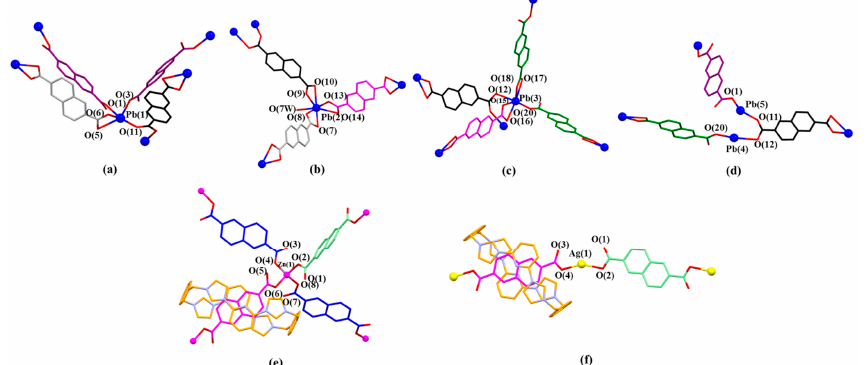
Figure 8. ( a )Coordination modes of Pb(1) and surrounding O donors. Selected interatomic distances [Å] for metal cation Pb(1) complexation: Pb(1) …O(1) 2.37(7), Pb(1)…O(3) 2.39(7), Pb(1)…O(5) 2.78(1), Pb(1)…O(6) 2.39(5), Pb(1)…O(11) 2.57(9); Selected interatomic angles for these contacts are: O(1)…Pb(1)…O(3) 82.9(8)°, O(1)…Pb(1)…O(11) 154.02°, O(1)…Pb(1)…O(5) 73.74°, O(1)…Pb(1)…O(6) 73.81°, O(3)…Pb(1)…O(11) 76.5(2)°, O(3)…Pb(1)…O(6) 77.7(3)°,